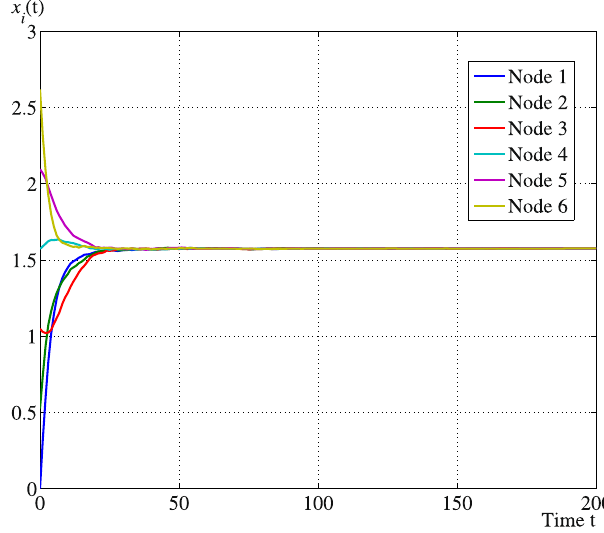
Figure 3. Trajectories